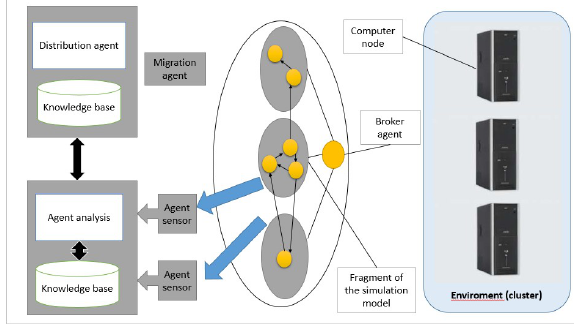
Figure 4: The architecture of the multi-agent balanc- ing